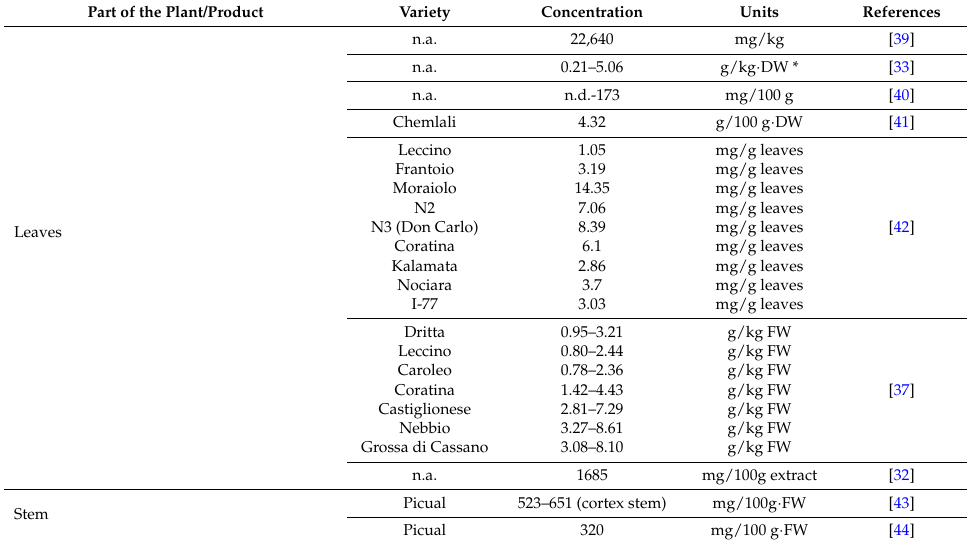
Table 2. Concentration of oleuropein in different parts of the olive plant or in different products. Part of the